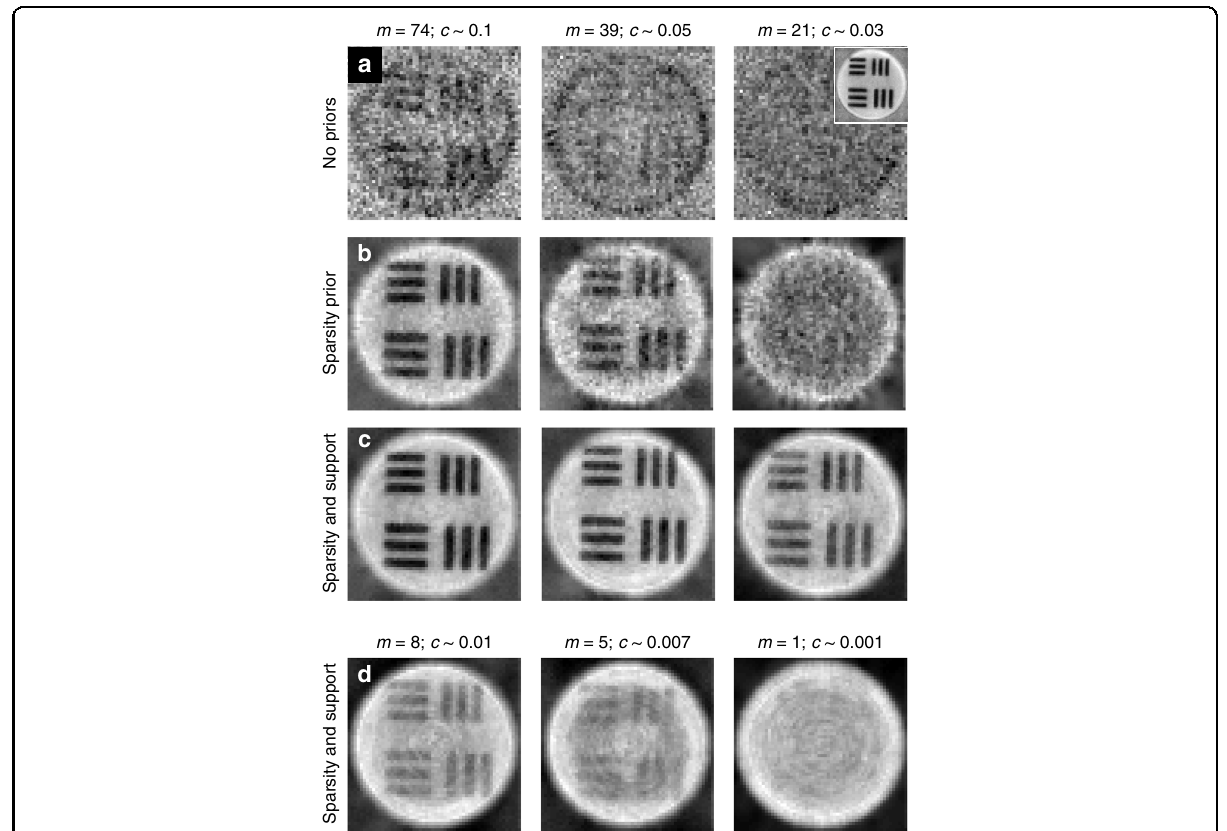
Fig. 3 Imaging using compressively recovered TMs. a When using a TM reconstructed with no priors, at progressively decreasing levels of sampling (from left to right), imaging is practically impossible at these compression levels. Inset: image captured using a fully sampled TM. b Images obtained using a TM reconstructed with a sparsity prior. c Results obtained using sparsity and support priors. d Results with sparsity and support priors at further reduced levels of sampling. In this case, no image is discernible when attempting to infer the TM from a single